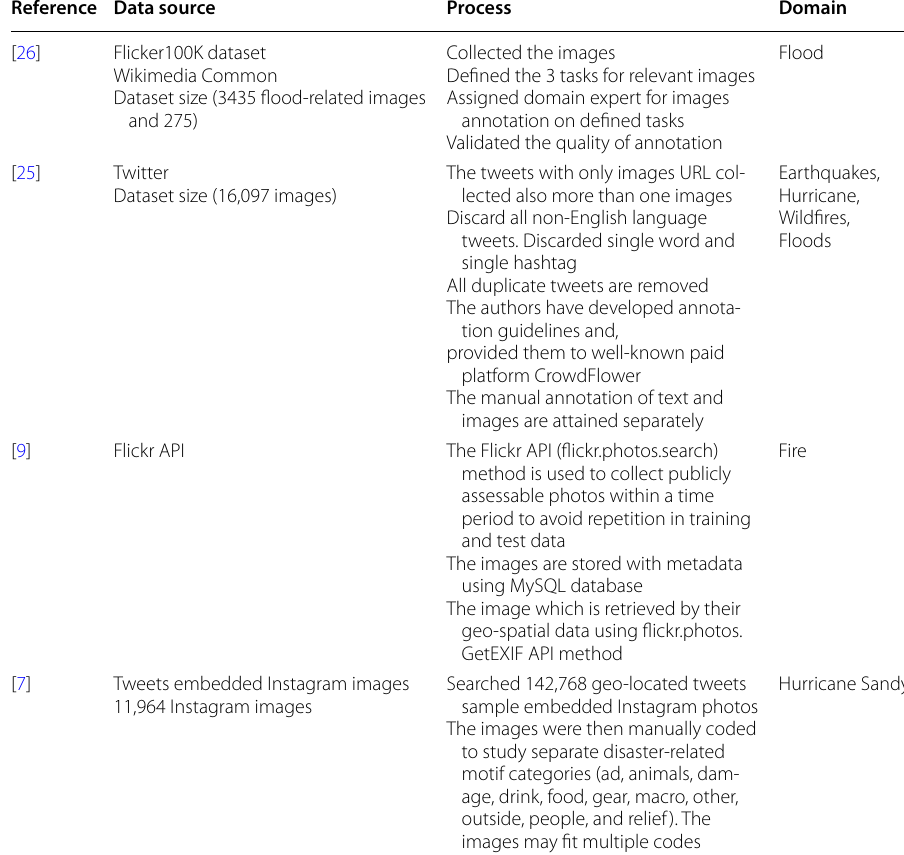
Table 3 The related work on disaster dataset